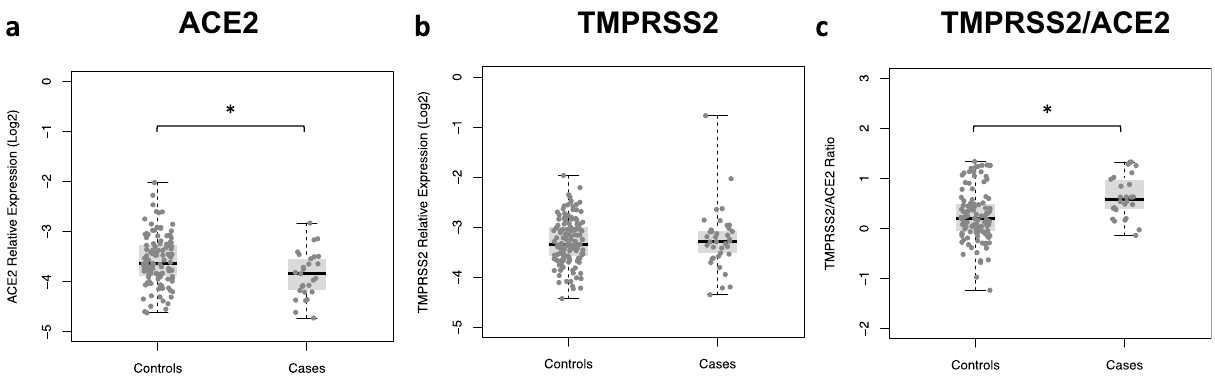
Figure 2. ACE2 and TMPRSS2 expression in COVID-19 patients with (cases) and without (controls) respiratory distress. Relative expression of both genes was determined by RT-qPCR using B2M gene as reference and results are shown in log-scale (base 2). Boxes represent mean and interquartile range, and whiskers represent upper and lower limit. Linear regression models were applied for comparisons of ACE2 ( a ) and